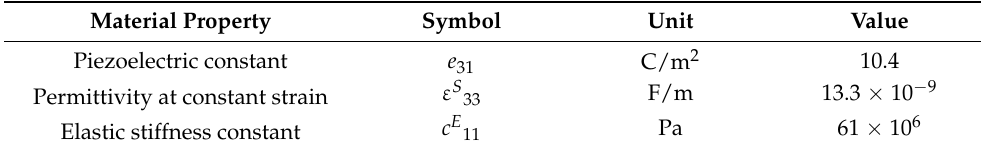
Table 3. Material properties of PZT-5A [33].